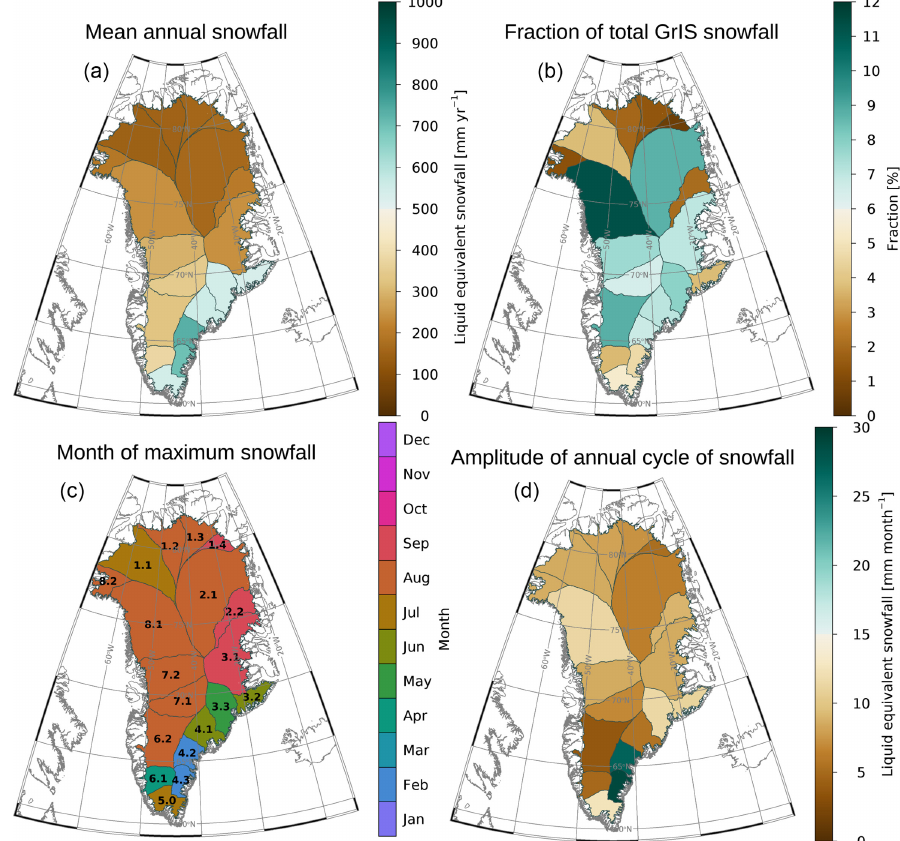
Figure 18. Annual snowfall associated with the different drainage systems defined by Zwally et al. (2012). Panel (a) shows the mean annual snowfall, panel (b) shows the fractional contribution to the total snowfall over the GrIS, panel (c) shows the month of maximum precipitation as well as the drainage-basin identifier used in Zwally et al. (2012), and panel (d) shows the amplitude of the annual cycle of snowfall. The month of maximum precipitation and amplitude are derived using a cosine fit to the annual cycle (see Fig.